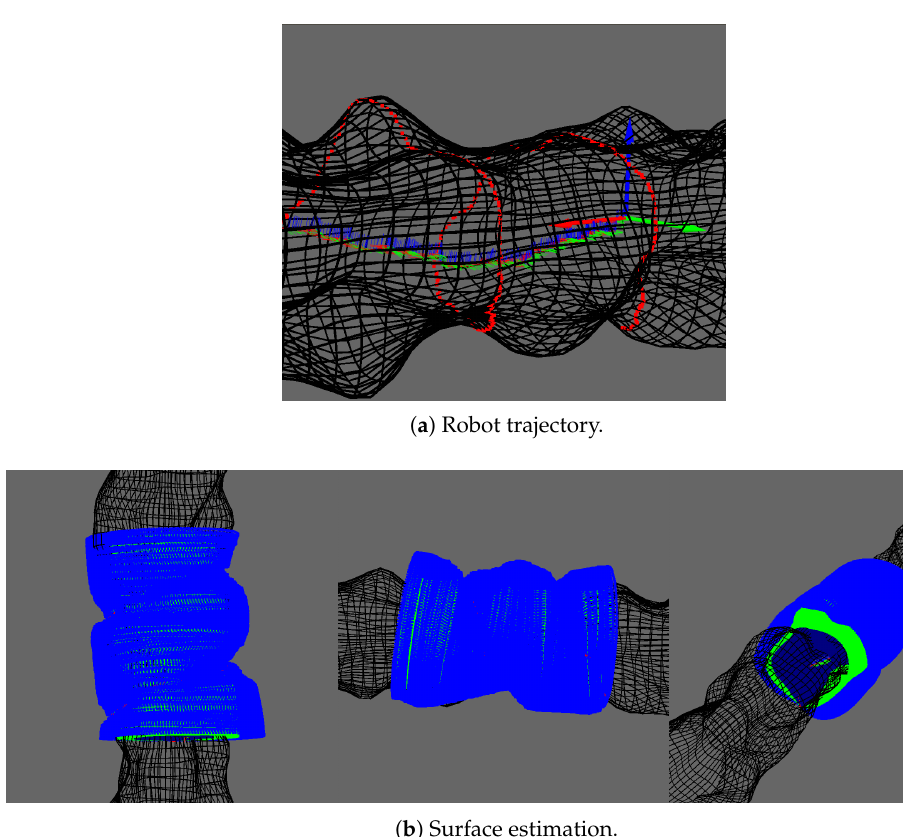
Figure 16. Surface estimation with a random